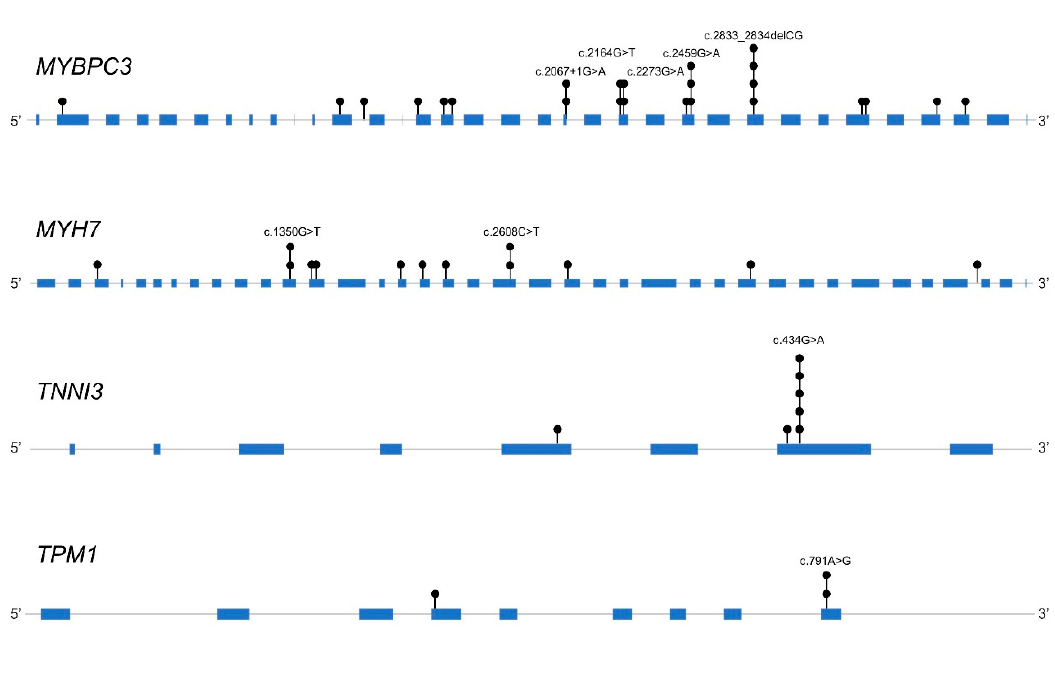
Figure 3. Distribution of variants in a gene where overlapping variants were